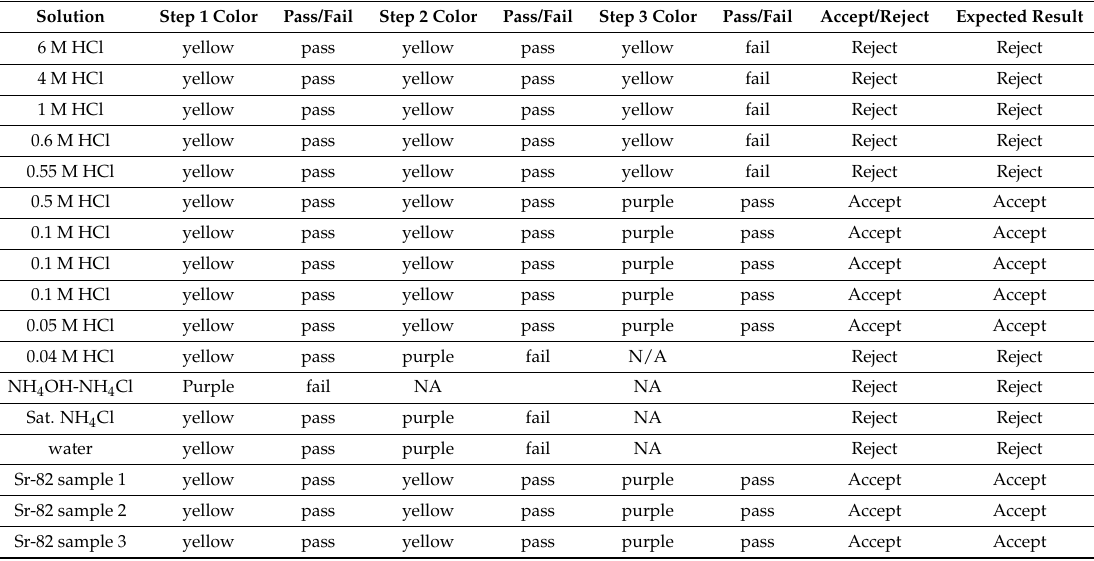
Table 1. Evaluation of the quality control assay for Sr-82